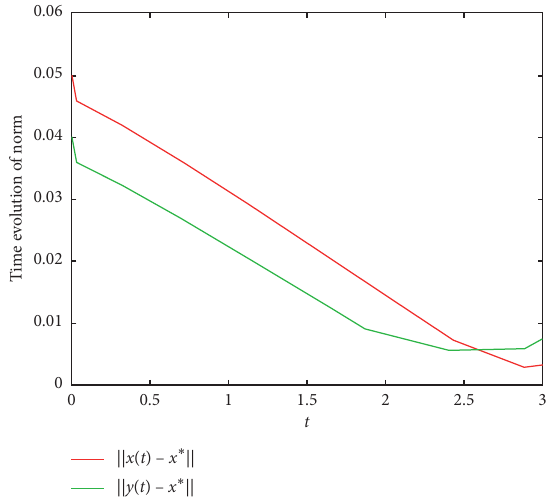
Figure 4: The time response for ‖ x ( t ) − x ∗ ‖ and ‖ y ( t ) − x ∗ ‖ .